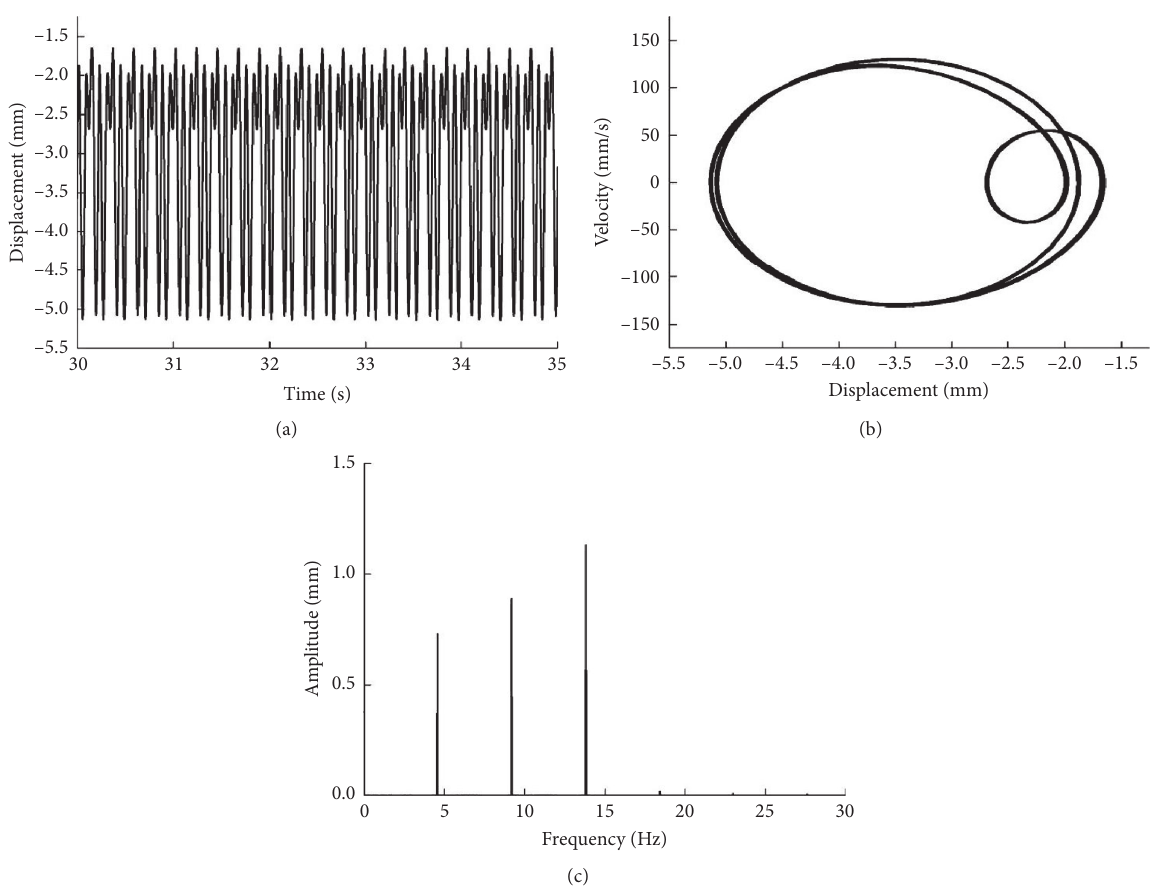
Figure 22: Period-3 motion of the system is obtained for the external excitation frequency Ω � 13 . 8 Hz: (a) waveform; (b) phase portrait; (c) amplitude